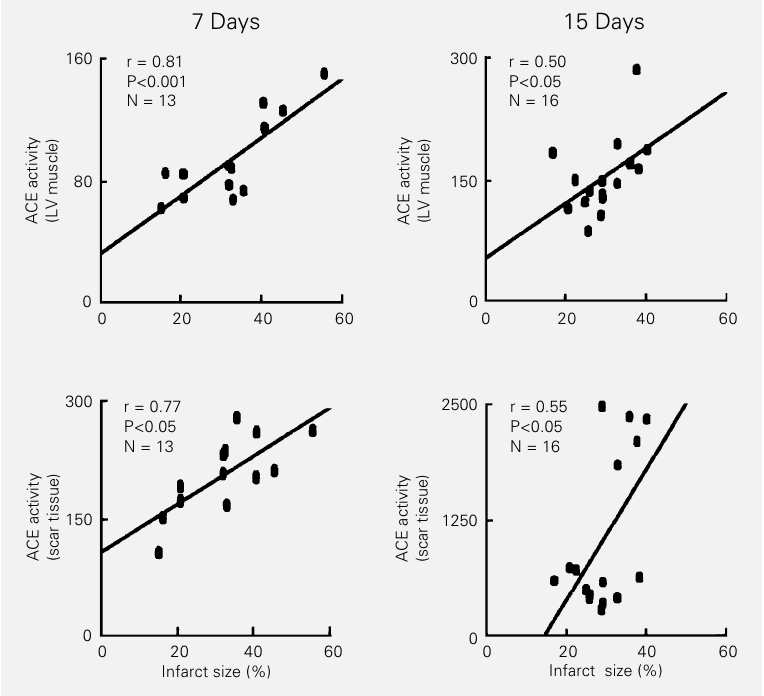
Figure 2 - Relationships between the infarct size and the angiotensin-converting enzyme (ACE) activity in the surviving left ventricular (LV) muscle (upper panels) and in the fibrotic scar (lower panels) of rats studied 7 or 15 days after myocardial infarction. ACE activity is reported as nmol His-Leu g -1 min -1 . The regression lines were calculated by the least squares method. r = Pearson(cid:146)s correlation